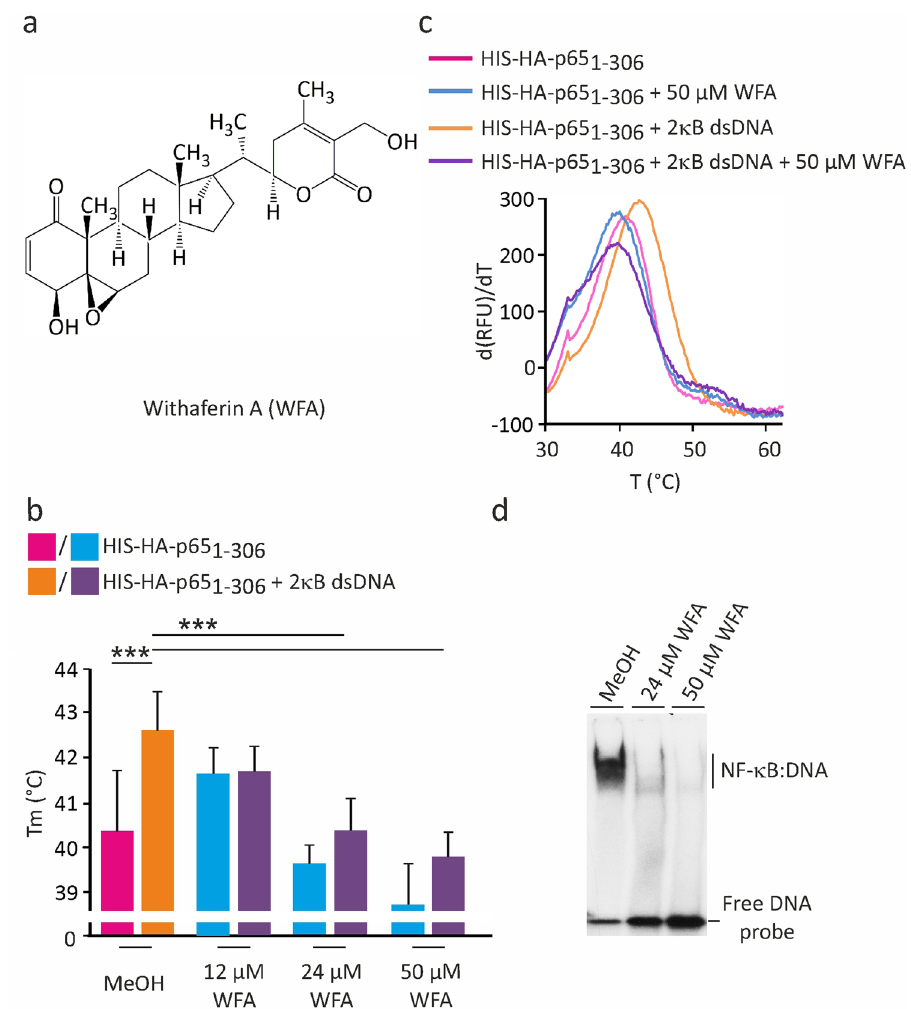
Figure 4. Effect of withaferin A on the dsDNA-induced p65/RelA thermal stability shift. ( a ) Chemical structure of WFA. ( b , c ) The thermal denaturation of p65 1-306 was measured in the absence and presence of 10 µM 2κB dsDNA and varying concentrations of WFA, as indicated. Representative derivative (d(RFU)/dT) curves are shown for untreated and treated with 50 µM WFA samples. Midpoint temperatures of the protein- unfolding transition (Tm) are presented as bars. Values are mean ± SD of at least three separate measurements (*** p < 0.001). ( d ) The inhibitory effect of WFA on the DNA-binding activity of p65 1-306 was verified by